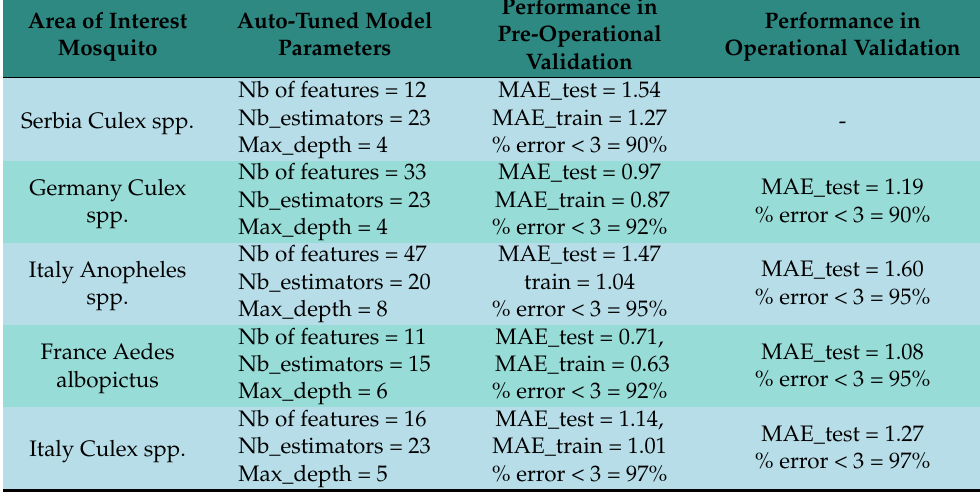
Table 3. MAMOTH’s performance per